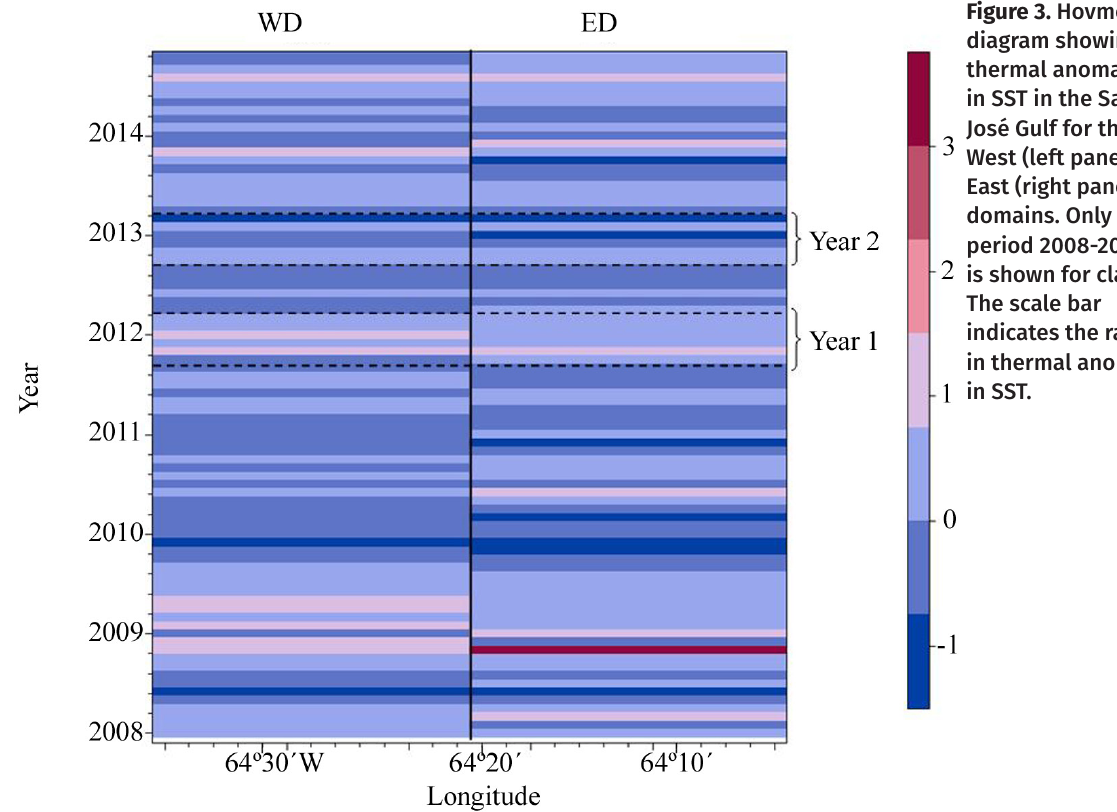
diagram showing the thermal anomalies in SST in the San José Gulf for the West (left panel) and East (right panel) domains. Only the period 2008-2014 is shown for clarity. The scale bar indicates the range in thermal anomalies in